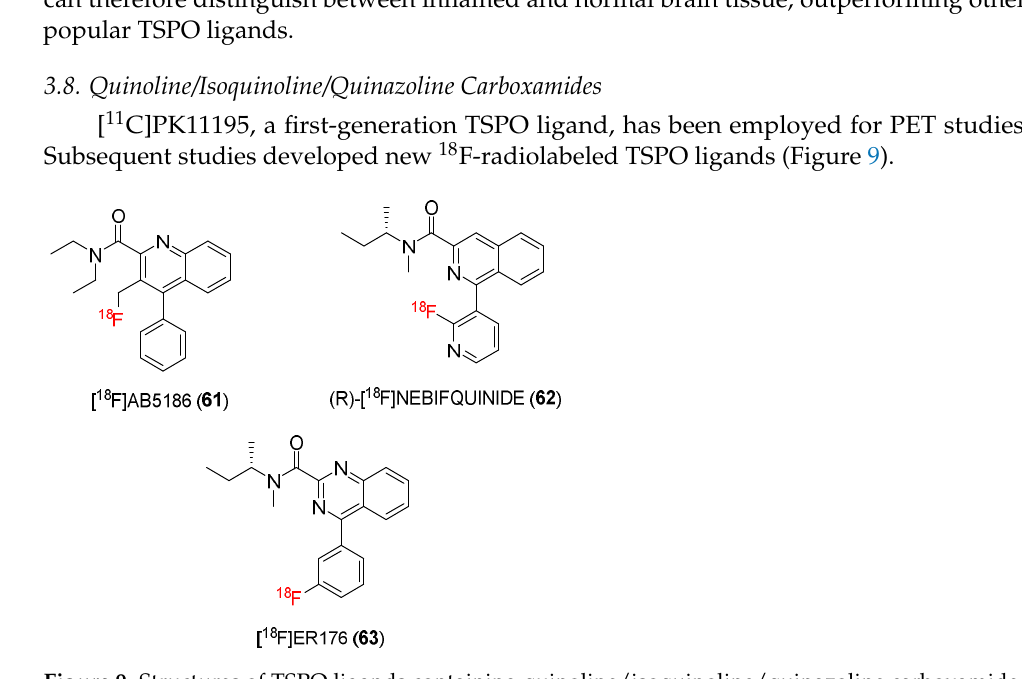
Figure 9. Structures of TSPO ligands containing quinoline/isoquinoline/quinazoline carboxamide.